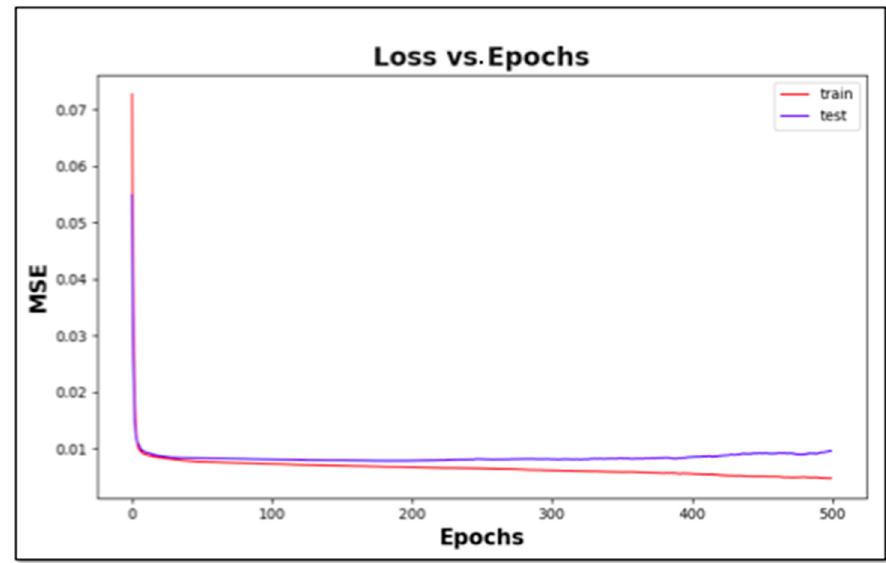
Figure 8. The graph of training and testing of data with LSTM model for 500 epochs.